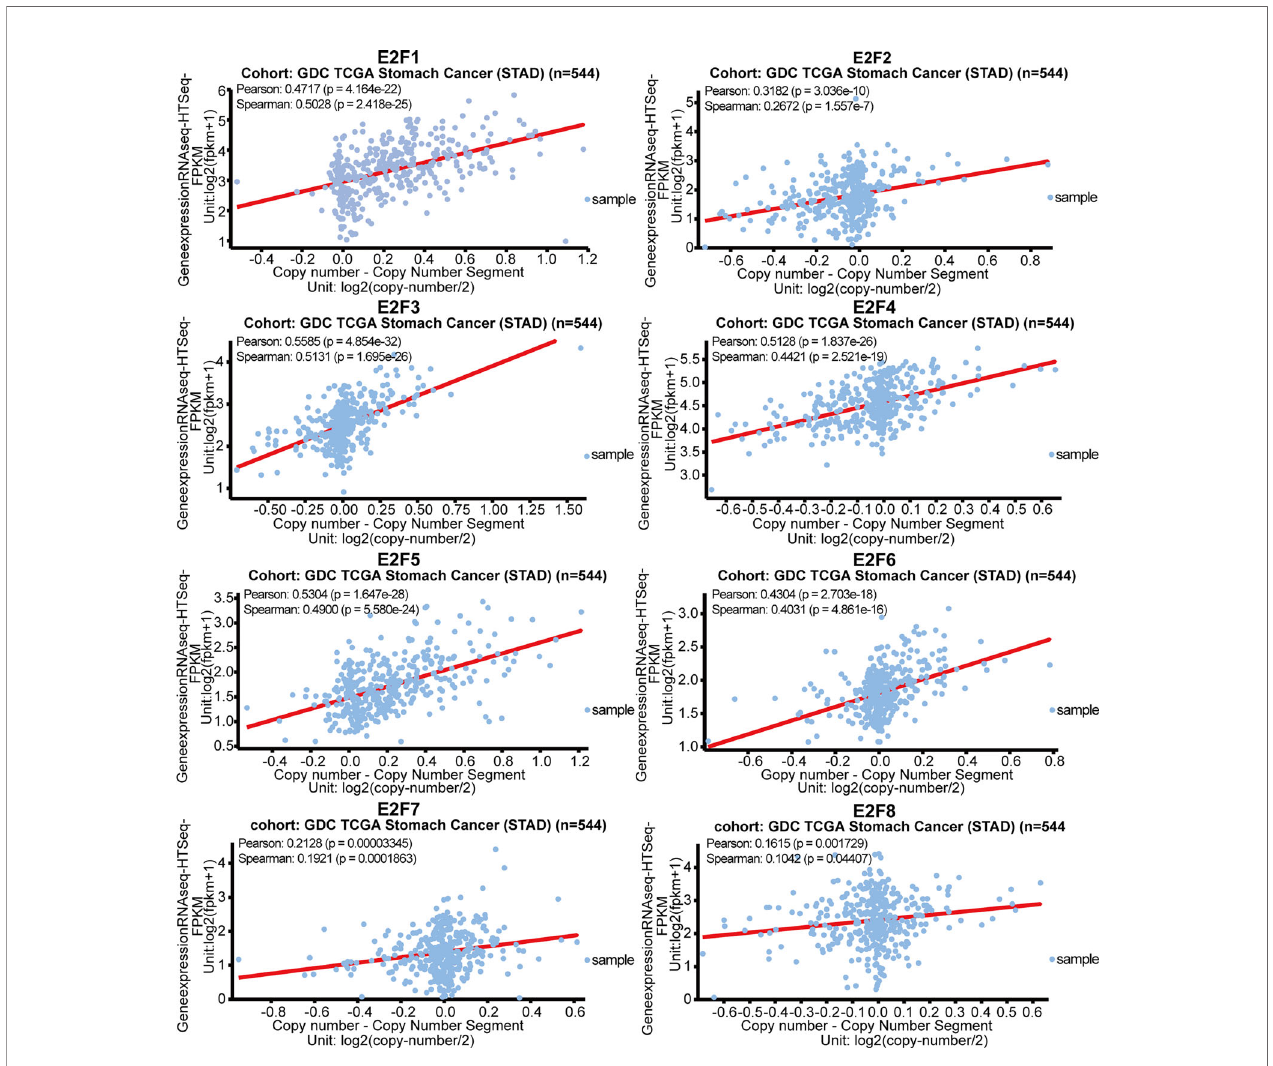
FIGURE 10 | Correlations of gene copy numbers with mRNA levels of E2Fs in STAD (UCSC